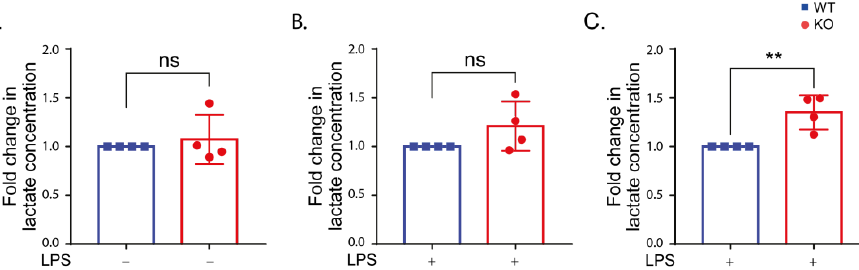
Figure 7. LRRK2 affects lactate production after 24 h LPS stimulation. ( A – C ) Lactate levels in the supernatant of WT and KO cells under control conditions ( A ) and after LPS stimulation for 6 ( B ) and 24 h ( C ). The experiment was performed 4 times and t-test was used to compare the average amount of lactate in the KO normalized to the corresponding WT. Error bar represents mean ± SD. p -values indicating statistically significant differences between the mean values are defined as follows: ns—not significant, ** p <